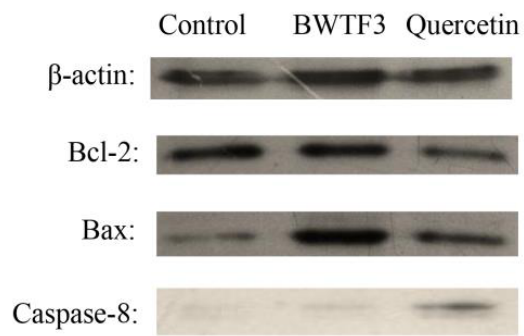
Figure 6. Effect of ethanol Extracts from tartary buckwheat sprouts powder on the expression of apoptosis-related protein in MGC80-3 cells.